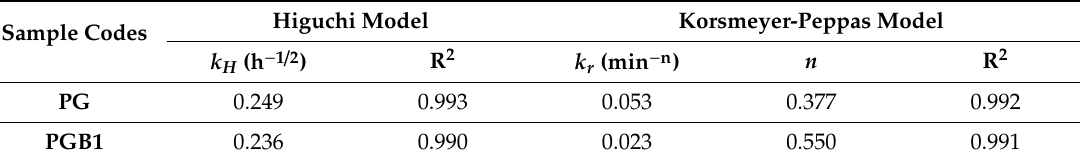
Table 2. Kinetic parameters of CF release from PG and